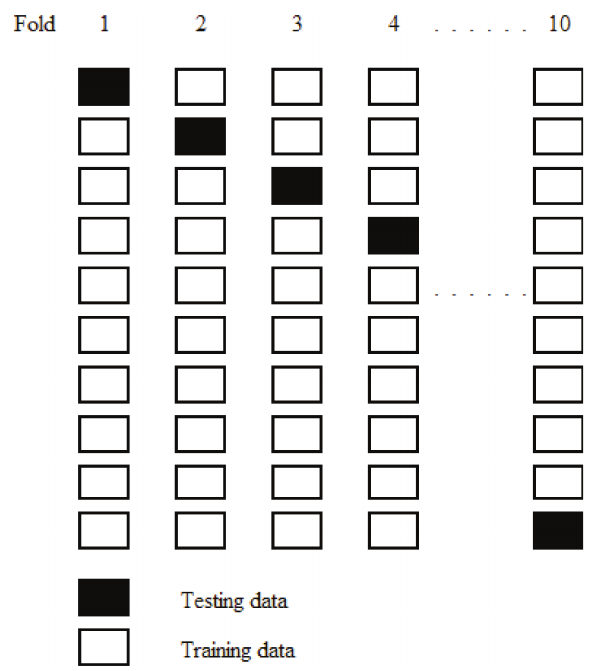
Fig. 7. 10-fold cross-validation